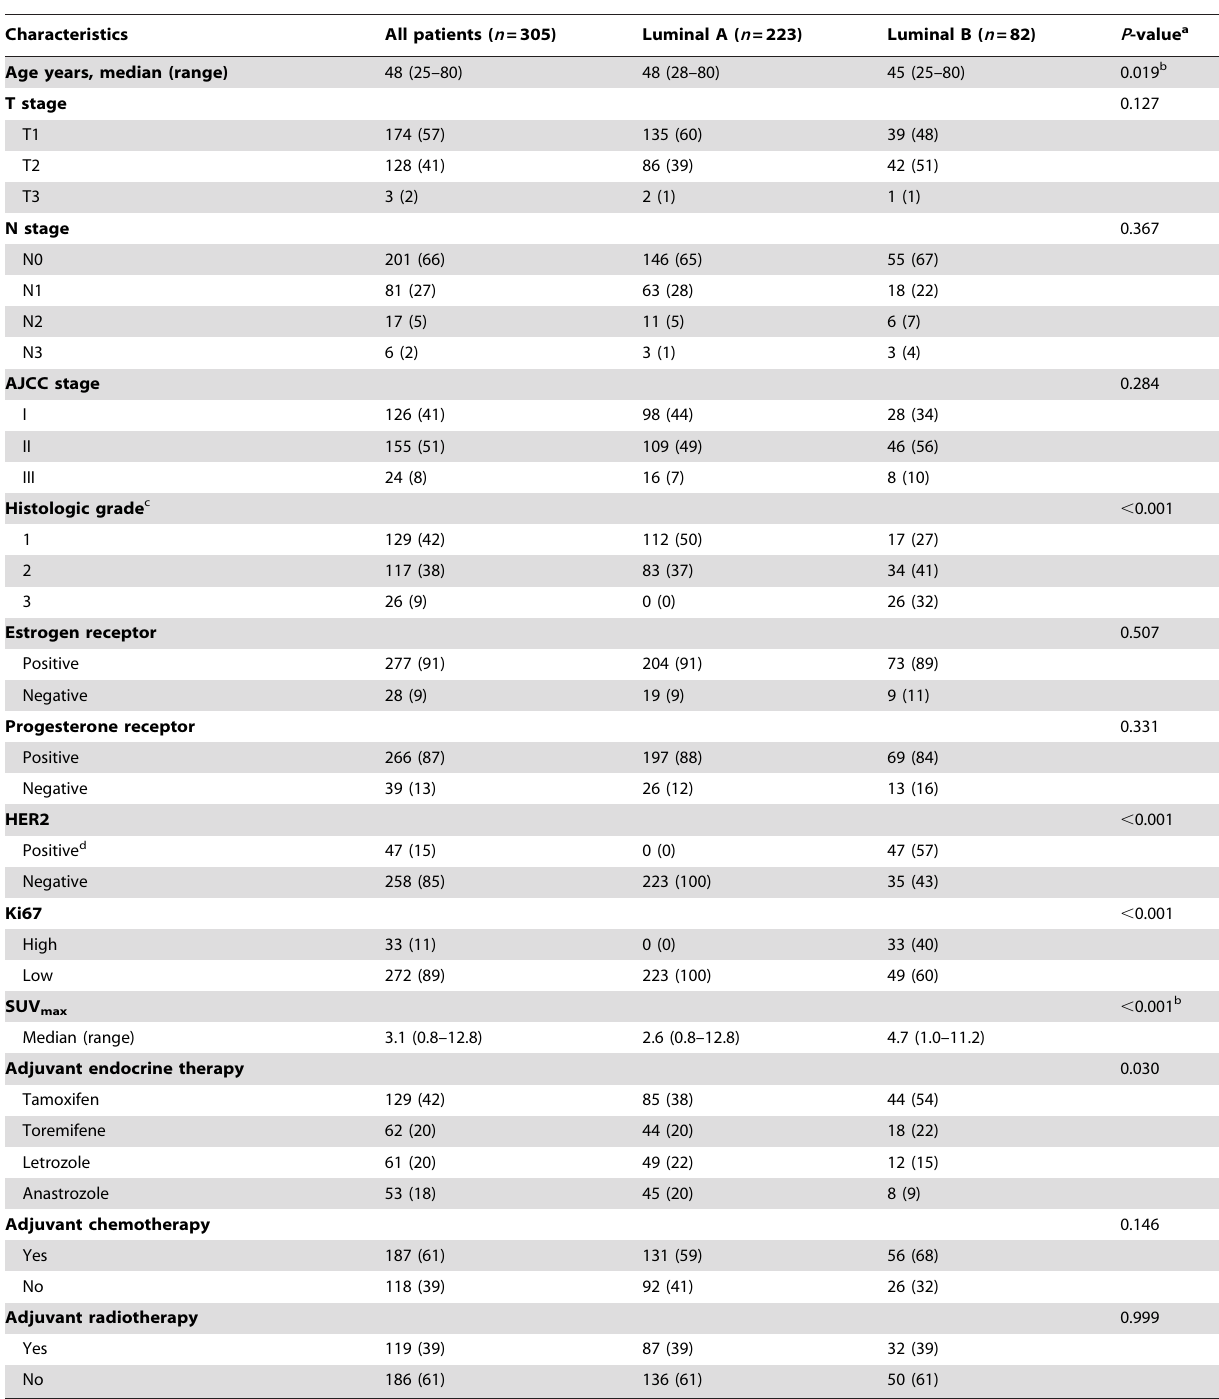
Table 1. Baseline characteristics of patients according to intrinsic